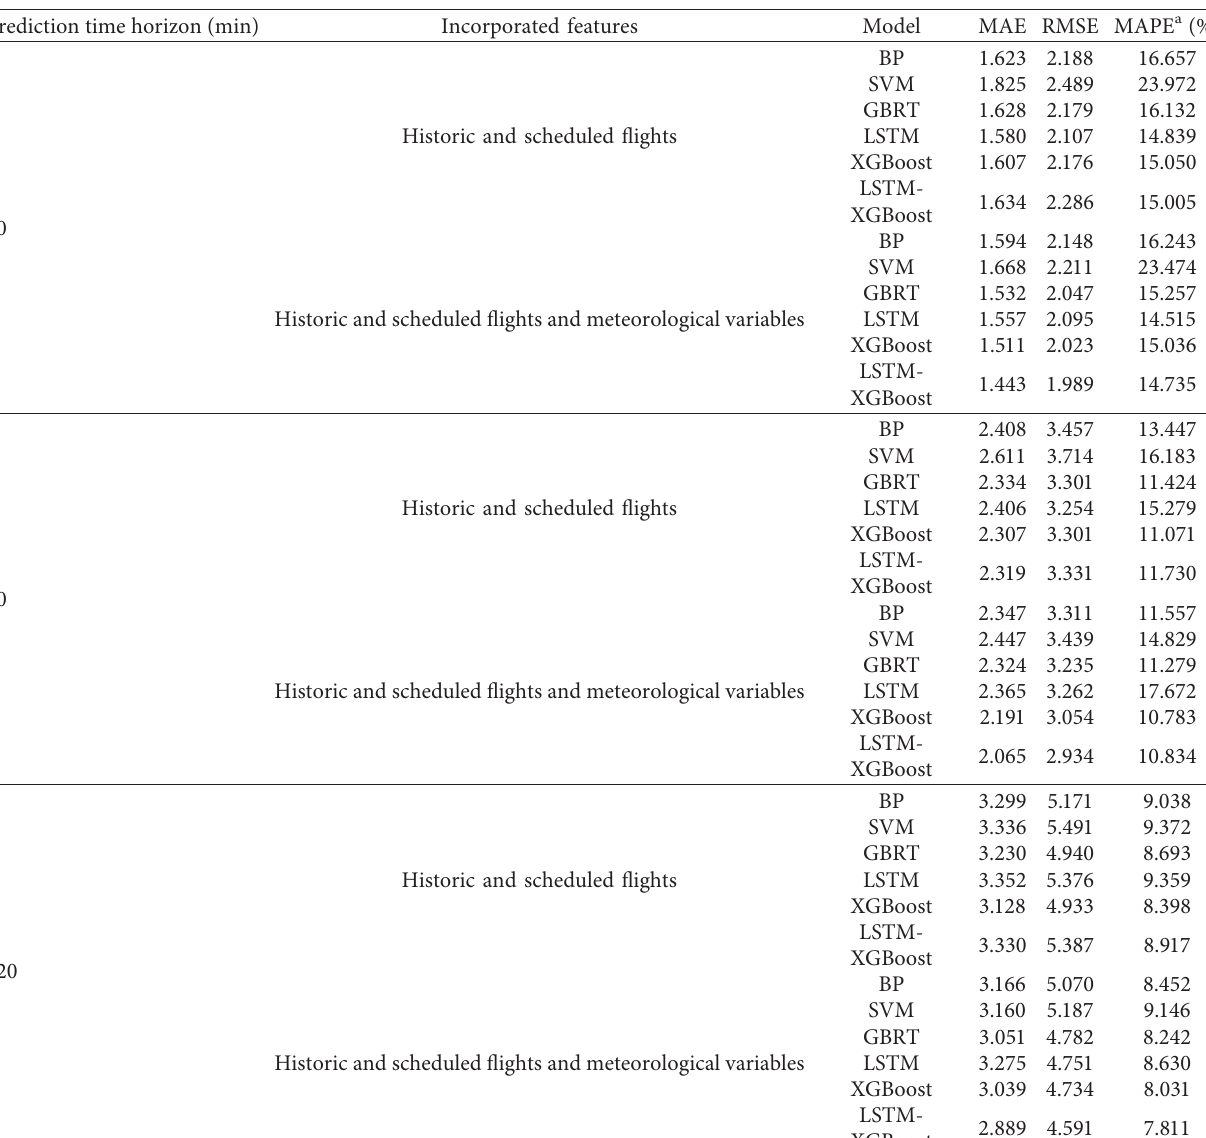
Table 3: Comparison of performances for different